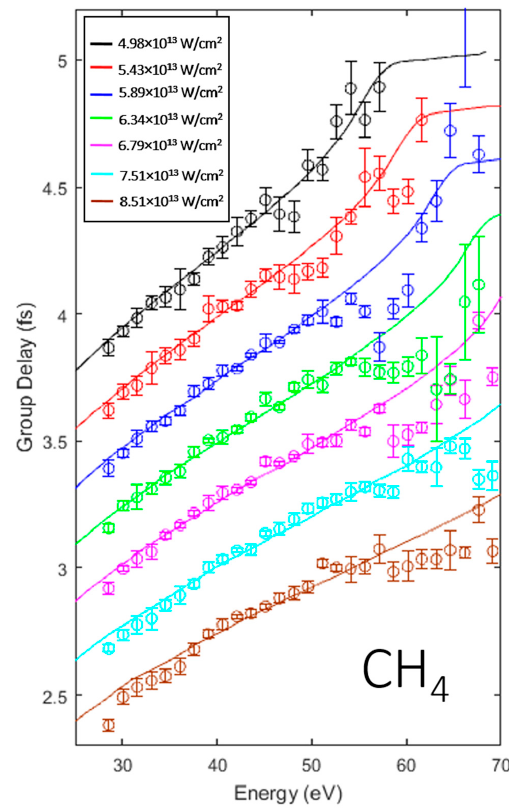
Figure 2. Laser intensity scaling in methane. Measured XUV group delays (circles) are shown from harmonic generation in methane, fitted with intensities as shown in the legend. As with the xenon scan of Figure 1, the lowest-intensity curve was fitted according to Equation (9), and scaled by the measured input power ratio for each additional scan (curves). Each intensity was separated by 0.2 fs for visual clarity.